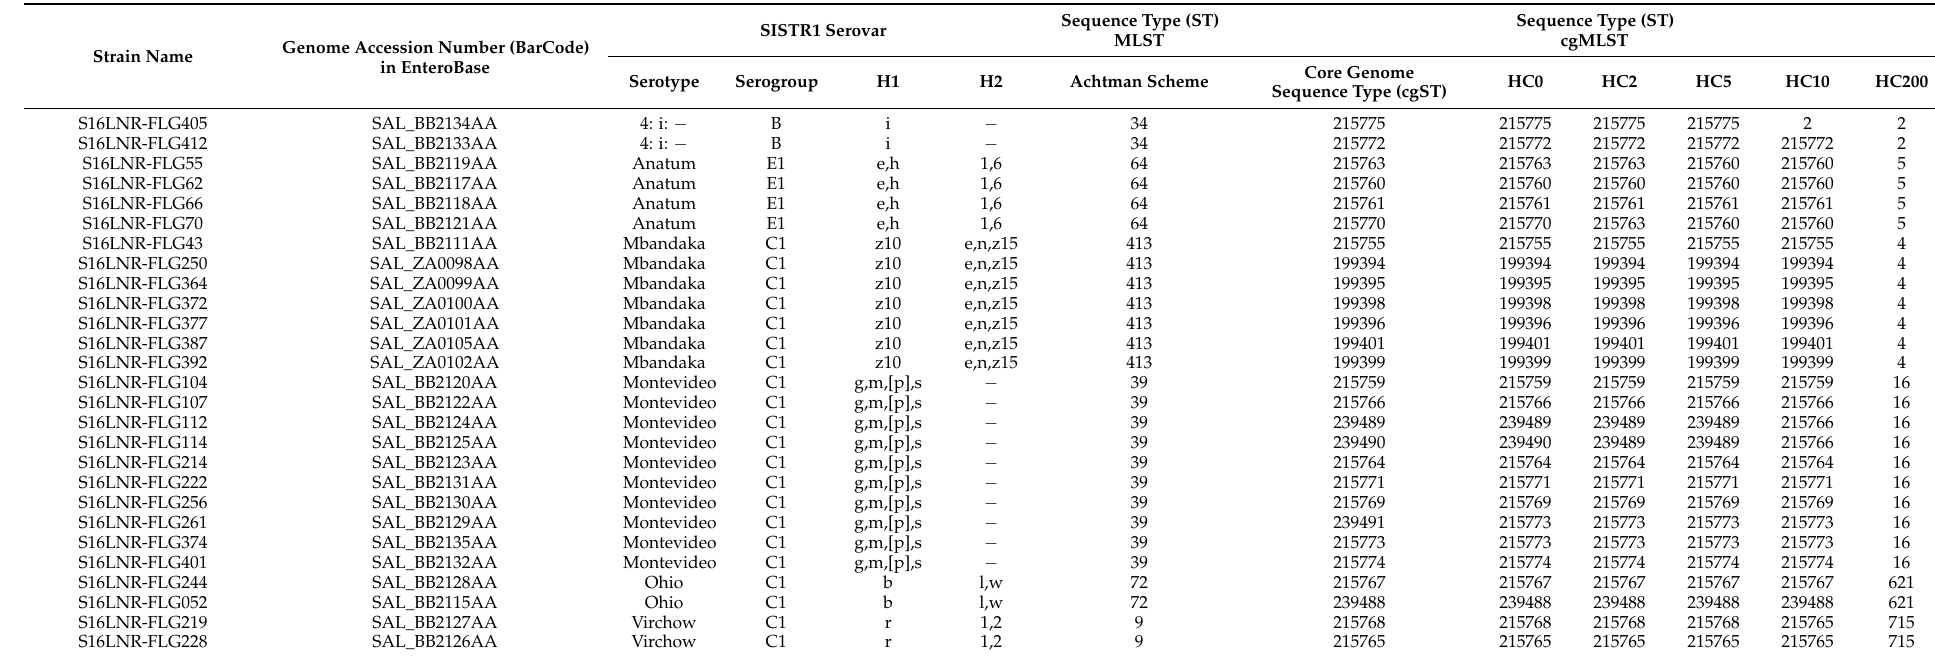
Table 3. Twenty-seven Salmonella strains sequenced in this study, serotypes, sequence type (ST) and core genome MLST (cg MLST)